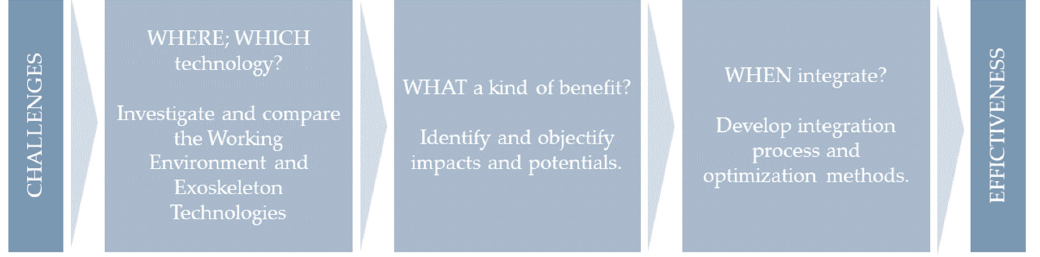
Figure 1. Objective: research questions, solution approach and hypotheses.